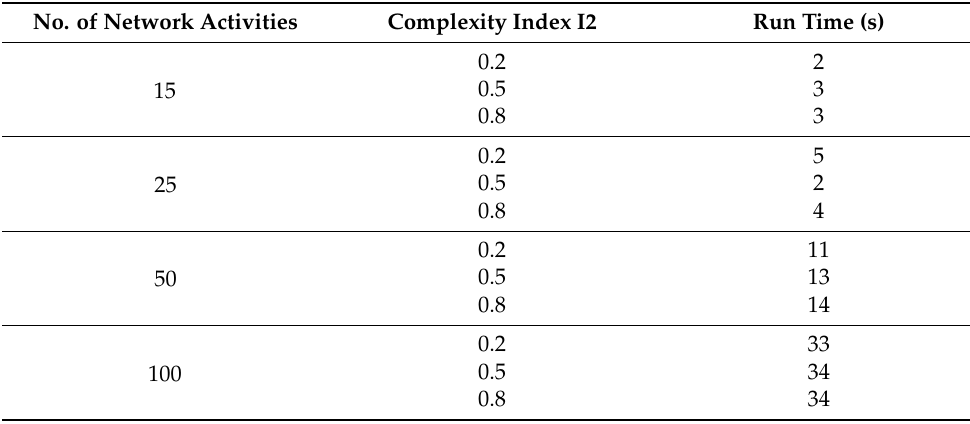
Table 3. Run times for variant network sizes with different